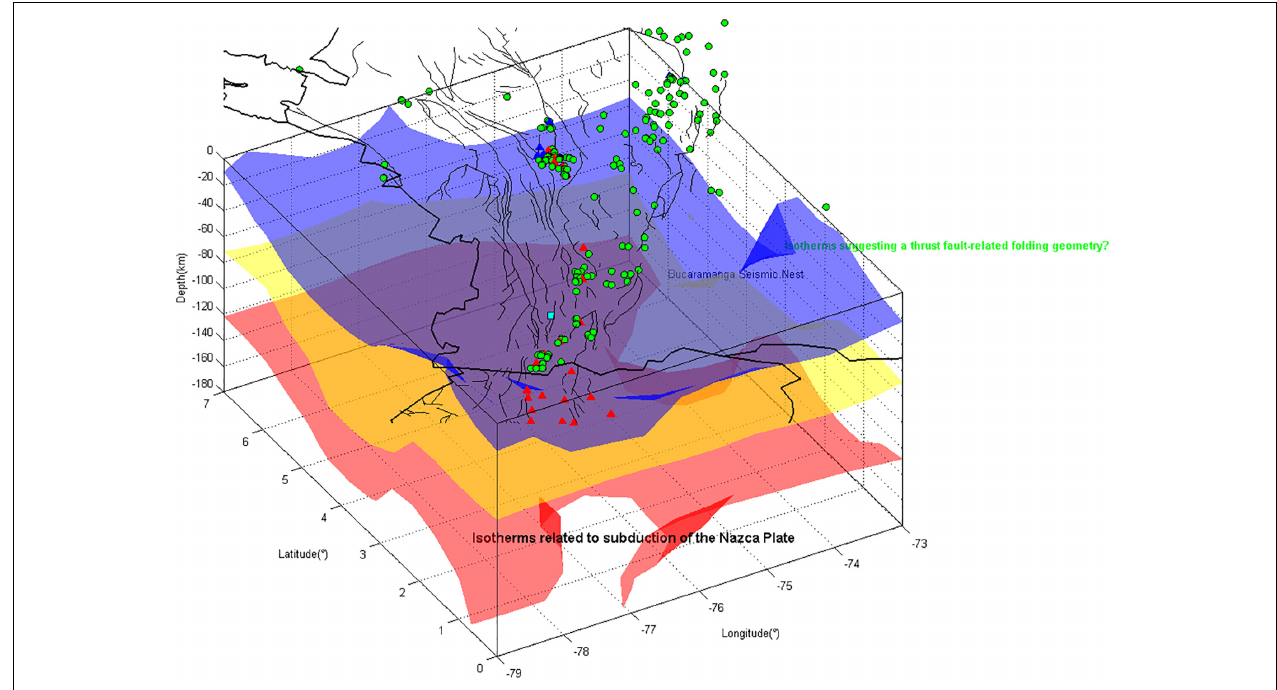
FIGURE 8 | 3-D view of isotherms 730 ◦ C (blue), 780 ◦ C (yellow), and 830 ◦ C (red). A video showing different views is provided as Supplementary Material . The model shows a perspective from SE, and allow to see irregular geometries of the isotherms, suggesting a recent process of thermal perturbation. Isotherms are deepening eastward, probably following the dip of the subduction of the Nazca Plate. The perspective also suggests a thermal trend similar to thrust fault-related folding geometries probably associated with recent tectonic collision processes. Some text have been included to highlights reference places. Thin continuous lines represent faults. Green circles correspond to hot springs. Triangles represent active (red) and inactive (blue)